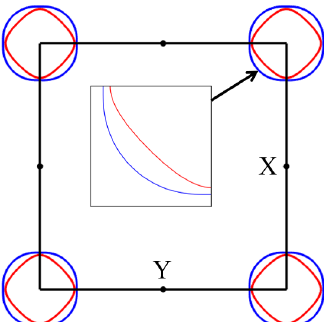
FIG. 6. The typical Fermi surfaces in the monolayer FeSe or LiFe(OH)FeSe in the presence of spin-orbit coupling, with the details shown in the inset. A sign reverse between the super- conducting orders on the inner and outer Fermi surfaces, which leads to topological superconductivity as shown in Fig. 3(a), are indicated by the red and blue colors in the